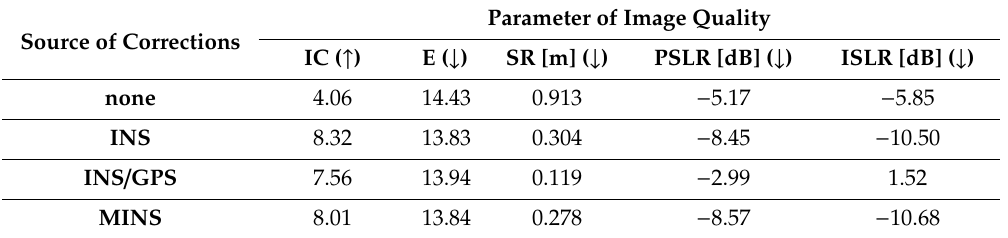
Table 2. Parameters of the quality of the selected synthetic aperture radar (SAR) image.